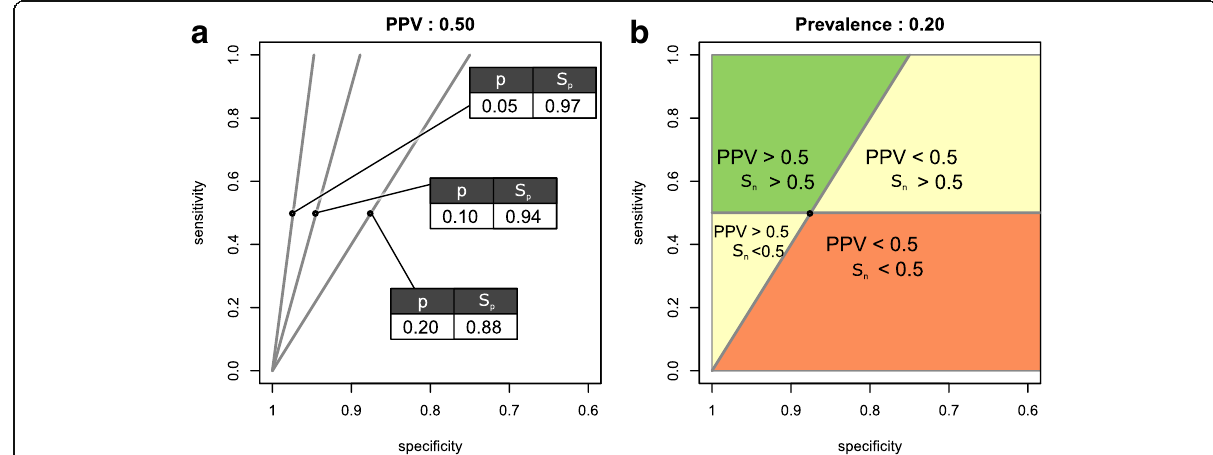
Fig. 3 Illustrations of positive predictive value thresholds. a Impact of prevalence: equi-PPV lines for fixed positive predictive value (PPV = 0.50) and three different prevalence values; i.e. 0.05, 0.1 and 0.2. b Defining minimum predictive performance: division of the “ ROC space ” into four quadrants as defined by a PPV cut-off (PPV ≥ 0.50) and a sensitivity cut-off ( S n ≥ 0.50) corresponding minimum test requirements for a test to deliver clinically relevant prognostic performance (hypothetical). Only tests whose ROC curves cross both cut-off lines and have points in the upper-left quadrant (green) do outperform the minimum test